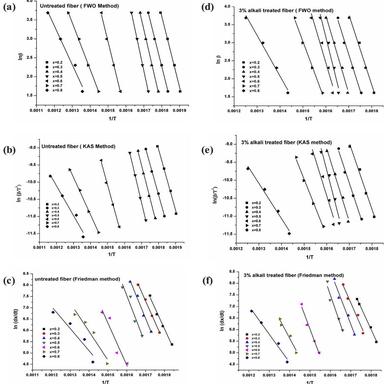
(a),(b,(c)FWO, KAS, Friedman plots of untreated fiber, (d), (e), (f) FWO, KAS, Friedman plots of 3% treated fiber.